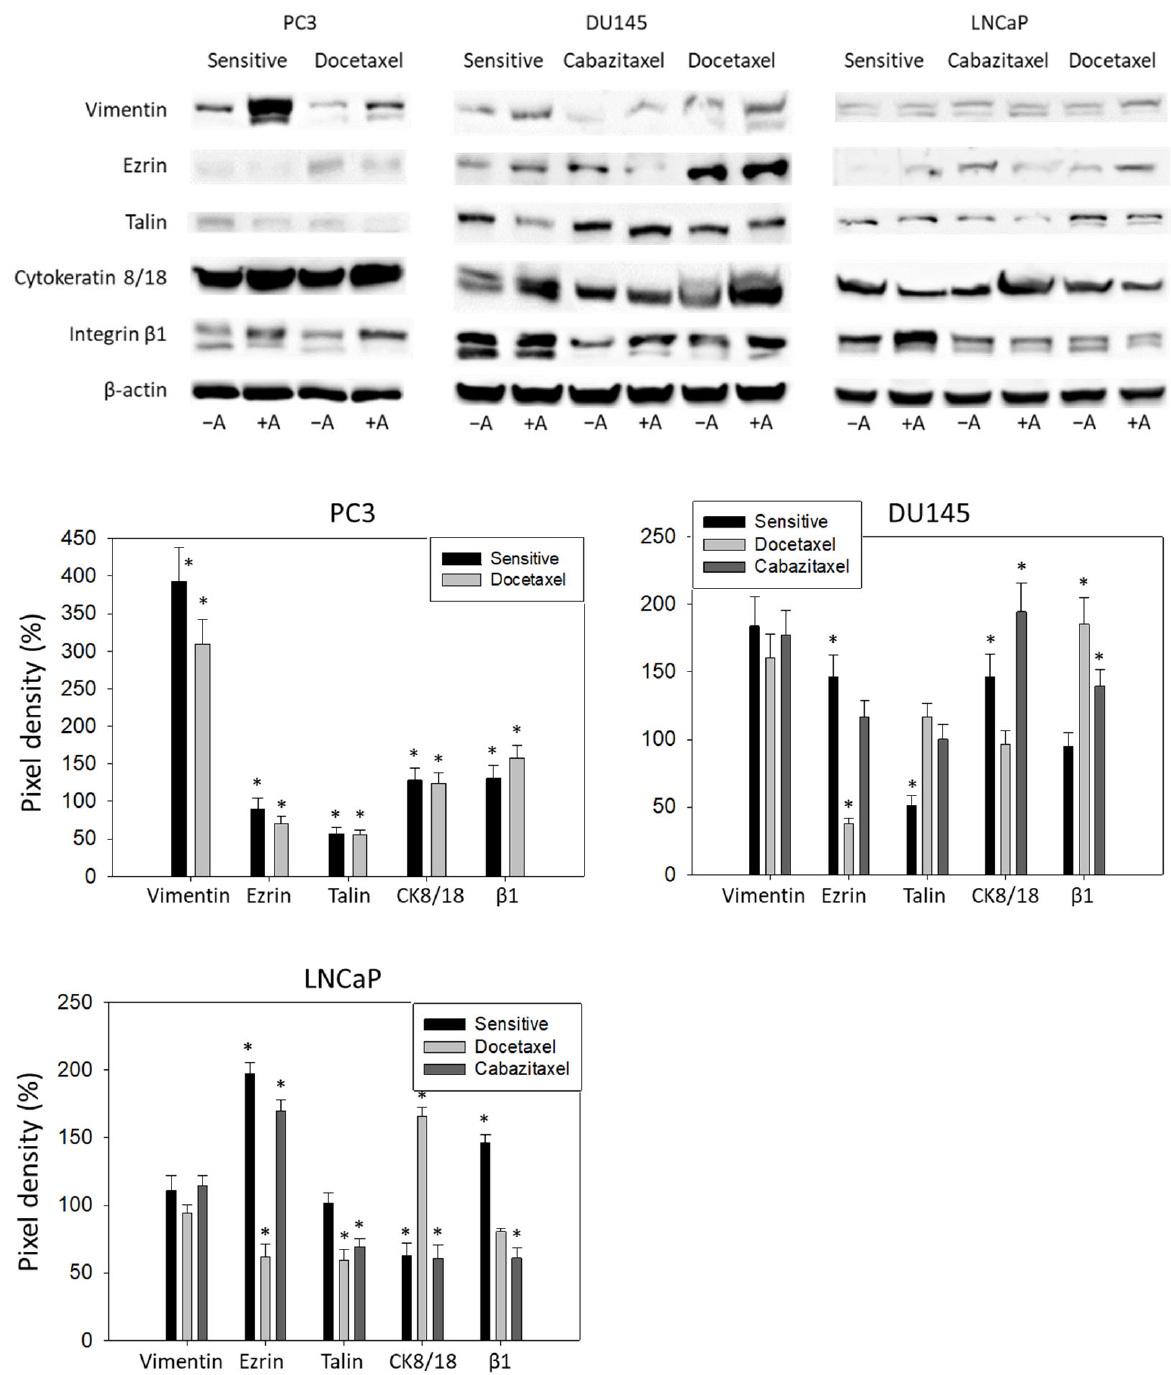
Figure 7. Up: Western blot of cytoskeletal proteins and integrin β 1 from drug ‐ sensitive and drug ‐ resistant PC3, DU145, and LNCaP cells. Tumor cells received either amygdalin (+A) or cell culture